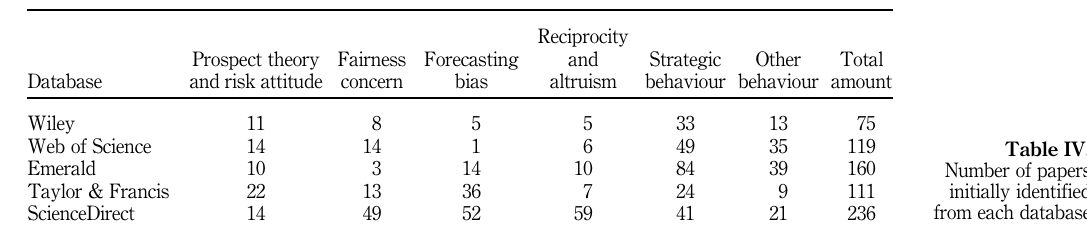
Table IV. Number of